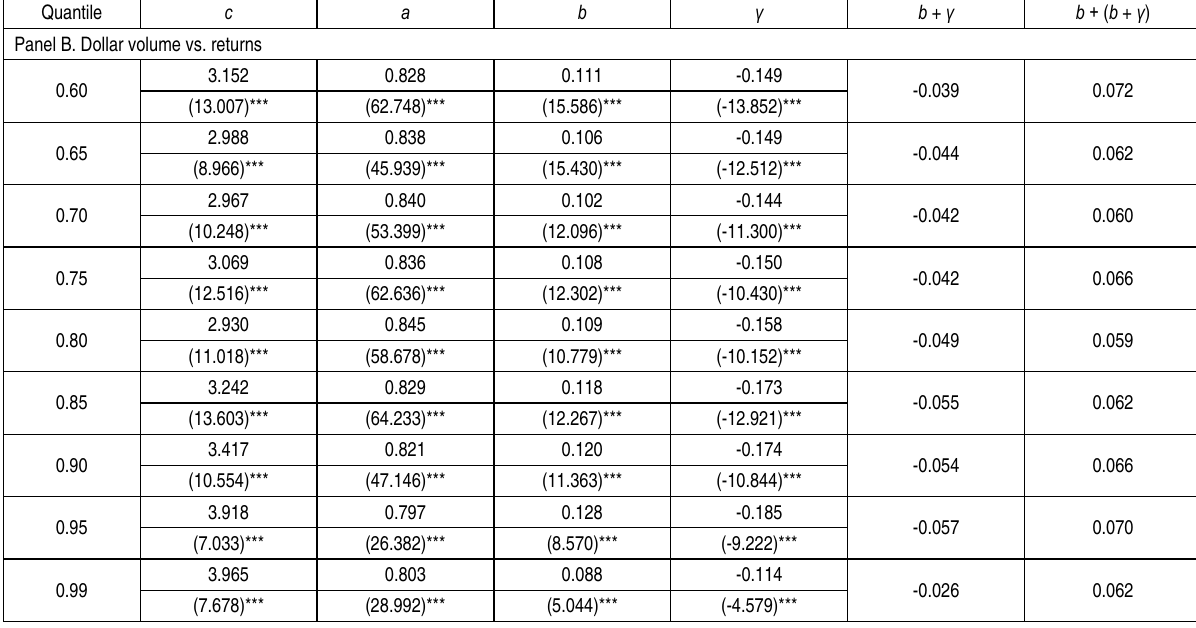
Table 7 (cont.). Quantile regression estimates of volume-signed return correlation for TAIEX in the partly-eliminated period